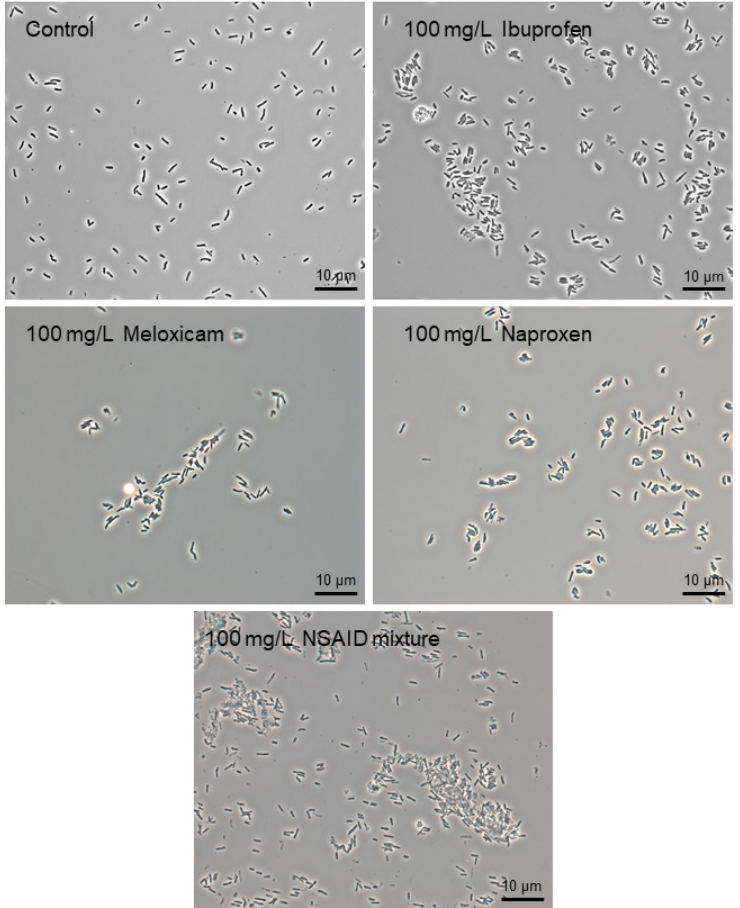
Figure 2. Phase-contrast images of R . cerastii IEGM 1278 grown in the presence of 0.1 g/L glucose (control), 0.1 g/L glucose and selected NSAIDs (ibuprofen, meloxicam, and naproxen), and their mixture. Cells were cultured for three days. × 1000.